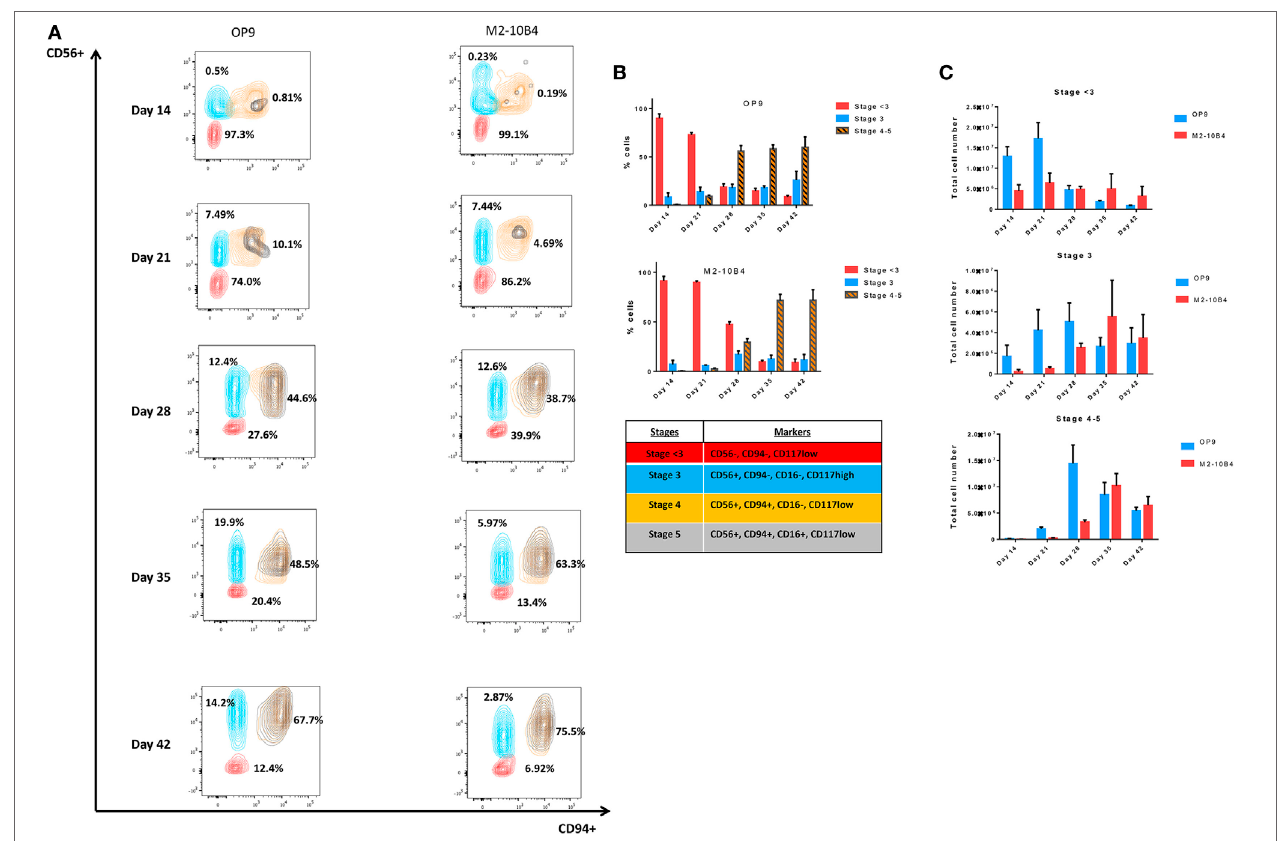
FigUre 2 | (a) Contour plots representing the different natural killer (NK) cell maturation stages during the differentiation protocol using OP9 and M2-10B4 cells as feeder layers. CD94, CD56, and CD16 markers were analyzed to determine the maturation stage as described in the text. Numbers represent the percentage of cells in stage < 3 (red), stage 3 (turquoise), and stages 4–5 (orange and black). (B) Percentage of NK cells in the different stages of maturation ( < 3, 3, and 4–5) along the differentiation time course. (c) Total number of cells in the different stages ( < 3, 3, and 4–5) cultured with the two conditions: OP9 and M2-10B4 cells coculture. The bars represent the mean and error bars represent SEM ( Stage < 3 : CD56 − , CD94 − , CD117 low ; Stage 3 : CD56 + , CD94 − , CD16 − , CD117 high ; Stage 4: CD56 + , CD94 + , CD16 − , CD117 low , and Stage 5 : CD56 + , CD94 + , CD16 + , CD117 low